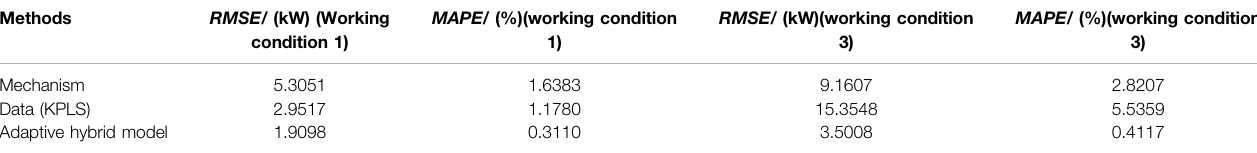
TABLE 4 | Calculation accuracy of different models under multiple working condition (working condition 1 and working condition 3). MAPE / (%)(working condition RMSE / (kW)(working condition MAPE / (%)(working condition Methods RMSE / (kW) (Working condition 1) 1) 3)